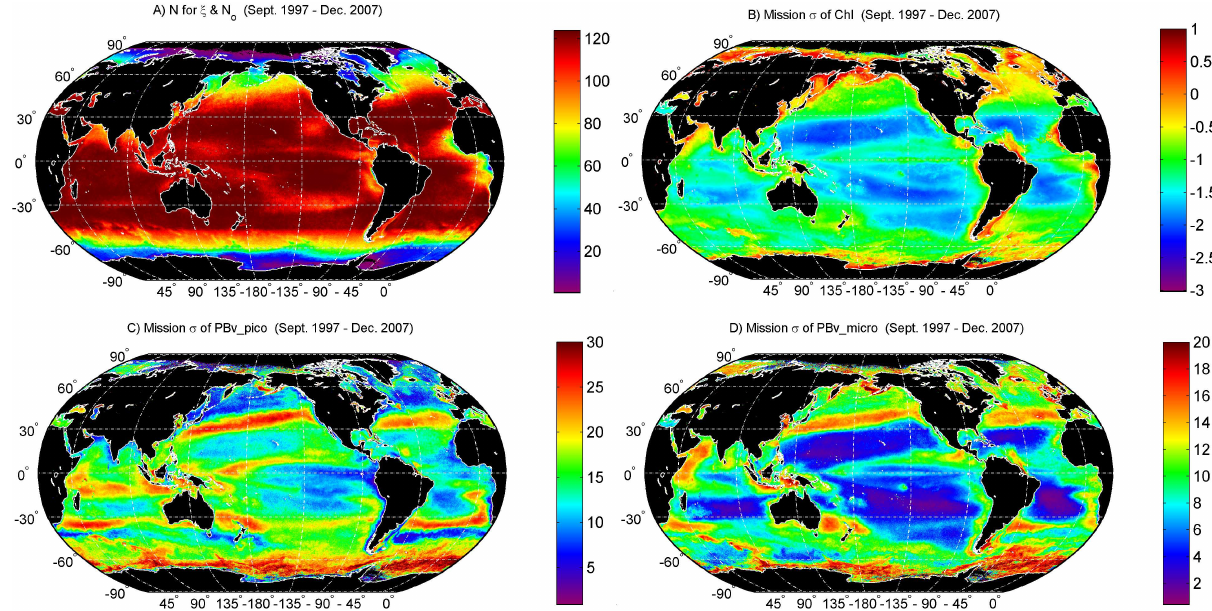
Fig. 7. (A) Map of the number of months of valid data used in the decadal averages computation for ξ and N 0 . Standard deviation maps for (B) Chl (mgm − 3 ) , calculated in linear space but shown on log10-based color scale, (C) the % picoplankton-sized particles of the total volume concentration and (D) the % microplankton-sized particles of the total volume